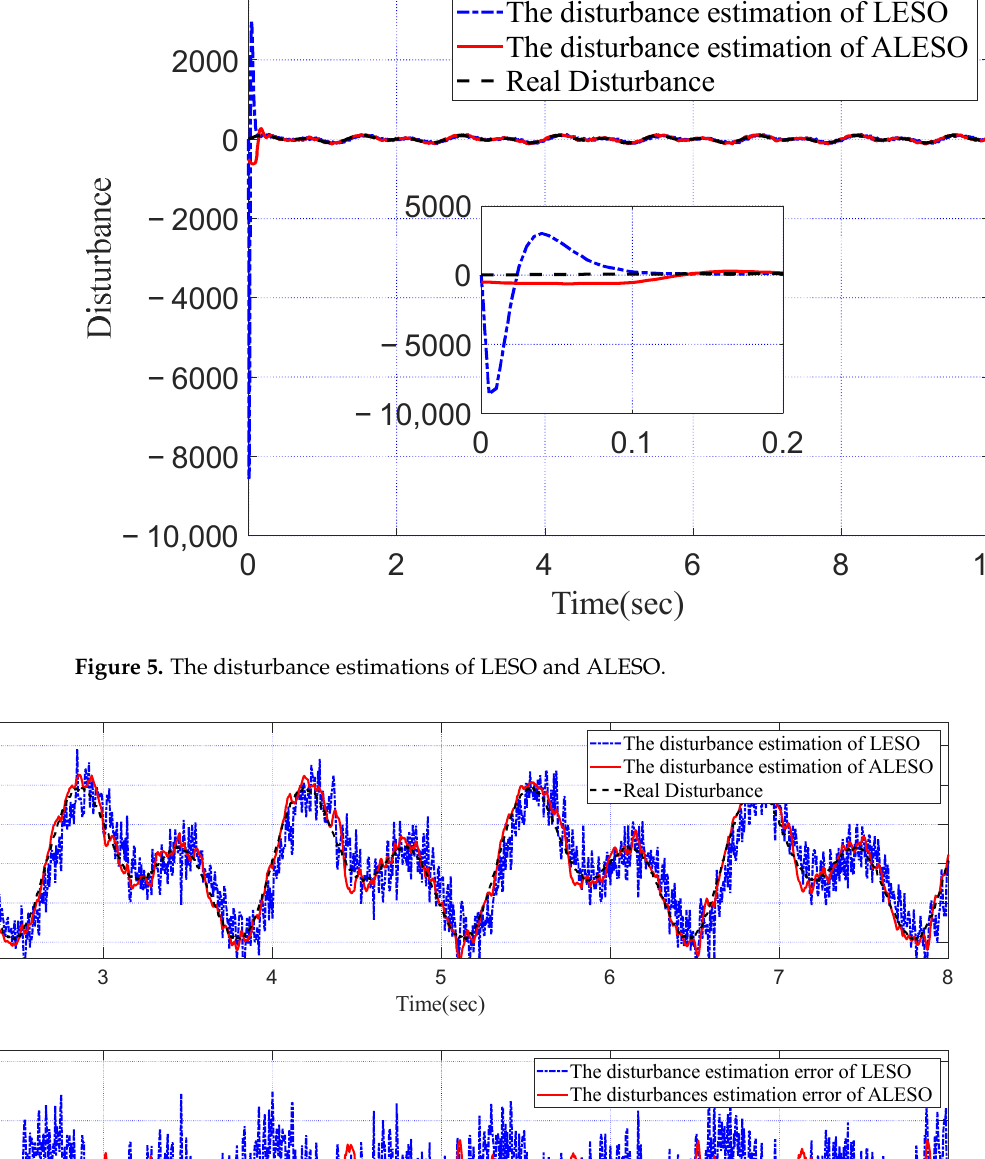
Figure 6. The disturbance estimations and errors of LESO and ALESO.